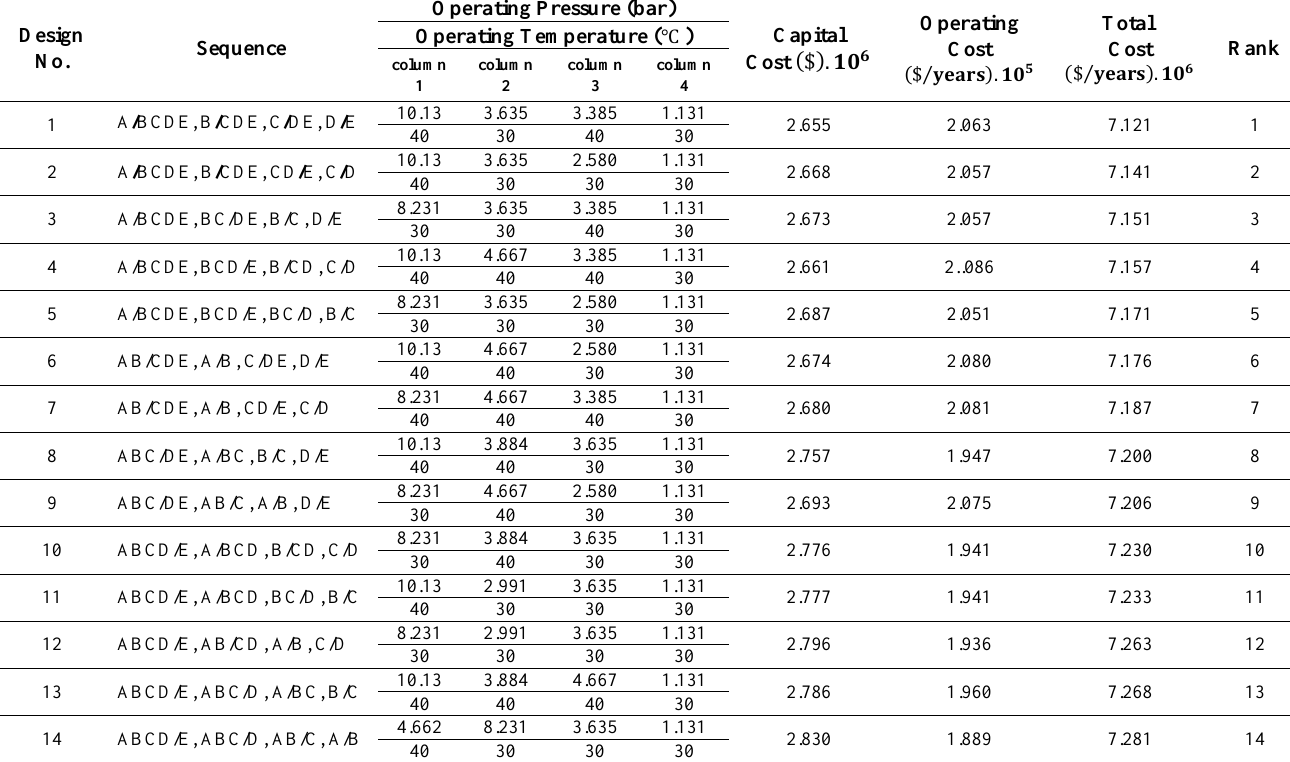
Table 8. Designing all of the feasible column sequences with variable temperature & pressure and have been ranked based on Total Annual Cost (TAC) as an object function.